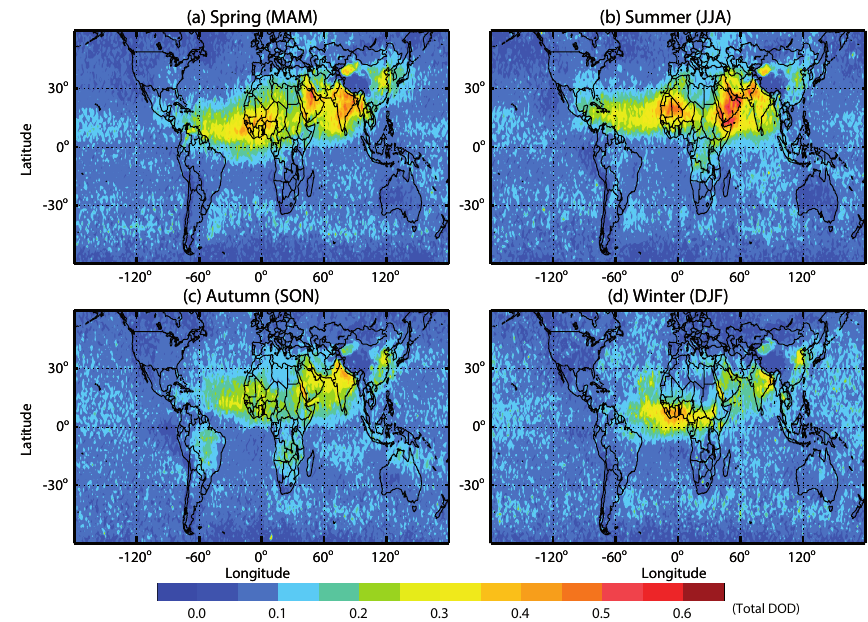
Figure 5. Global seasonal distributions of total (including polluted dust) dust optical depth derived from CALIPSO measurements (2007– 2010) for spring–winter, (a) – (d) ,